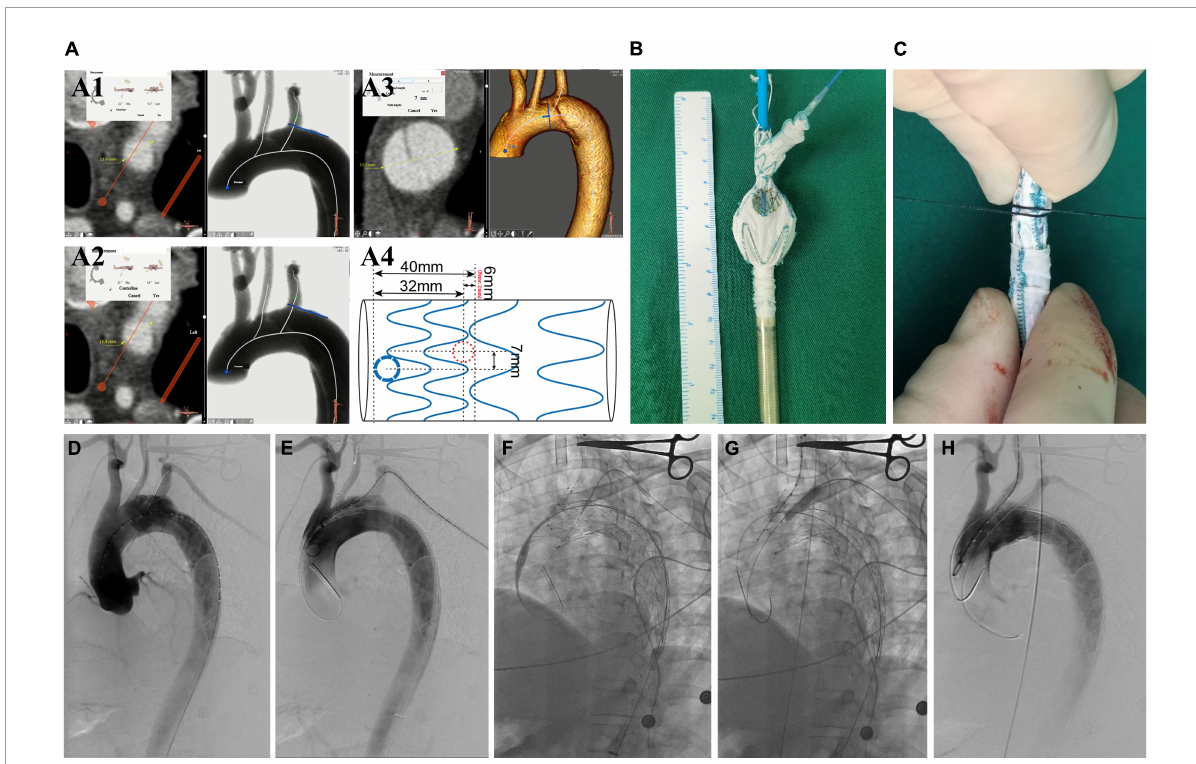
FIGURE2 The surgeon’s details modified fenestrated stent graft and the intraoperative images of performing this endovascular technique. (A1) Measuring the diameter of LCCA and the offset angle between LCCA and LSA. (A2) The diameter of LSA. (A3) The distance between the tear entry and the proximal side of the stent. (A4) A design for preparing the modified fenestrated stent graft. (B) The unsheathed custom-made fenestrated single-branched Castor stent graft and the distal circular fenestration site are selected for LSA. (C) Photography of stent-graft when re-sheathed. (D) DSA images in the left anterior oblique view. (E) Delivery and advancement of the stent graft into the aortic arch. (F) The hydrophilic guidewire is passed cephalad into the sheath through a needle hole and advanced through the stent-graft lumen, exiting through LSA fenestration and continuing cephalad external to the stent-graft. (G) On-table covered stent was implanted and balloon dilatation. (H) DSA shows the patency of aortic arch branches and no endoleak. LCCA, left common carotid artery; LSA, left subclavian artery; CTA, computed tomography angiography; DSA, digital subtraction